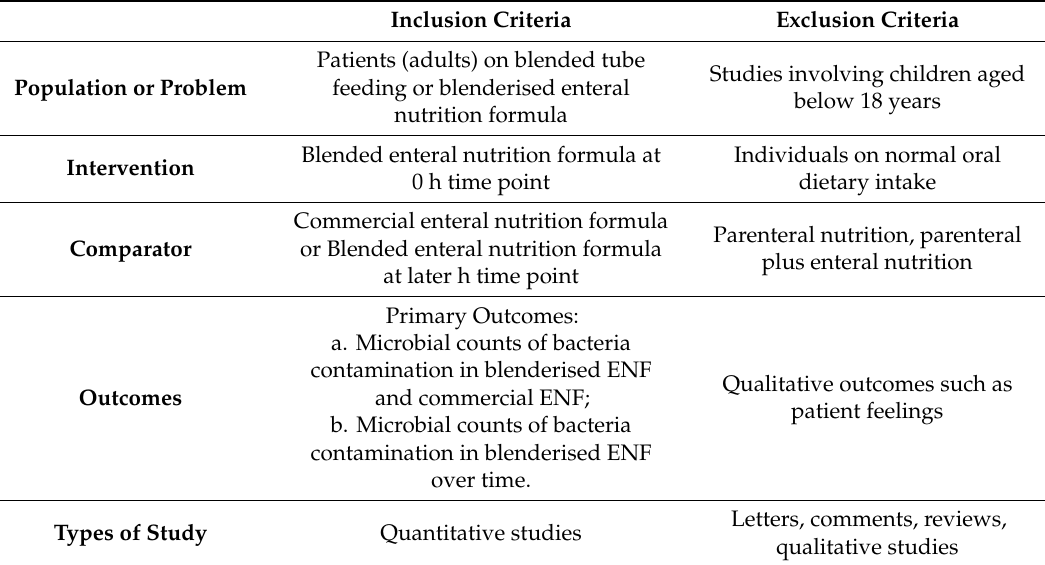
Table 1. Inclusion and exclusion